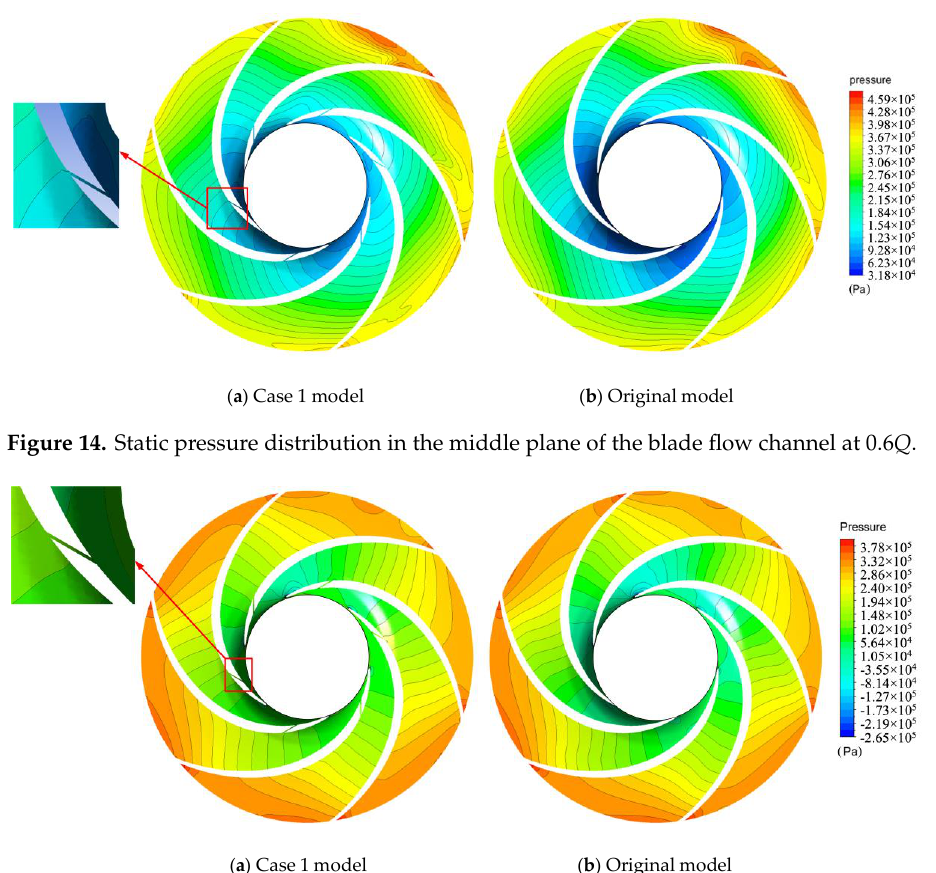
Figure 15. Static pressure distribution in the middle plane of the blade flow channel at 1.4 Q .